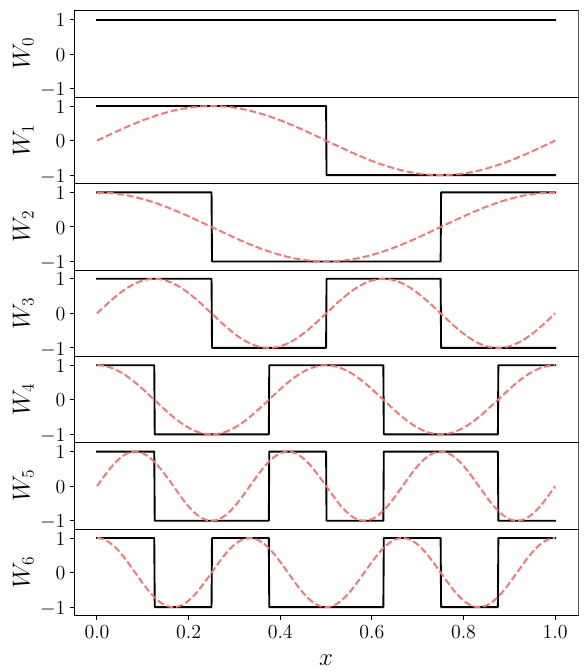
FIG. 16. The first seven Walsh functions in sequency